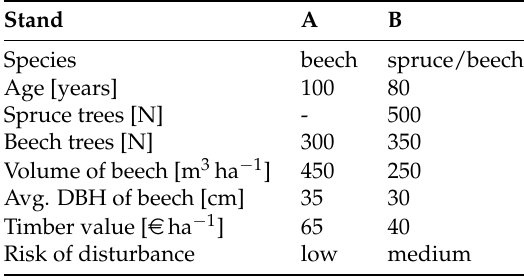
Table 1. Numerical example of where to provide a certain amount of deadwood. DBH is the diameter at breast height.